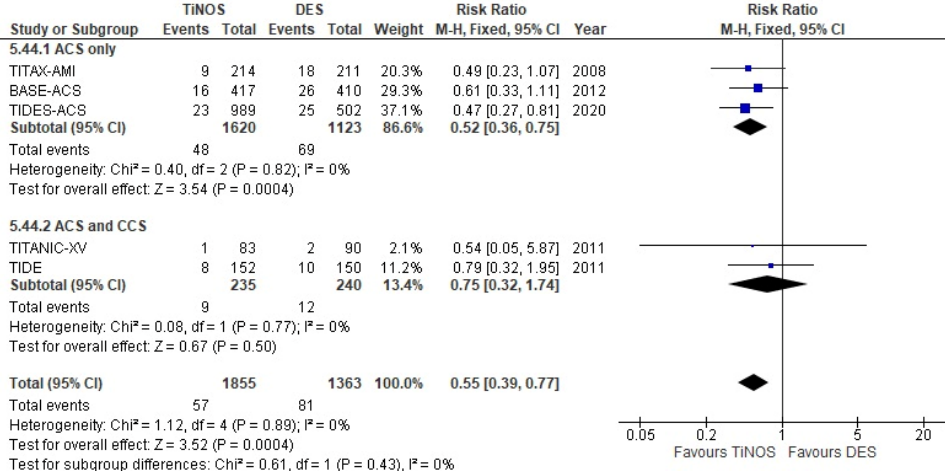
Figure 6. CD or MI—1 year.